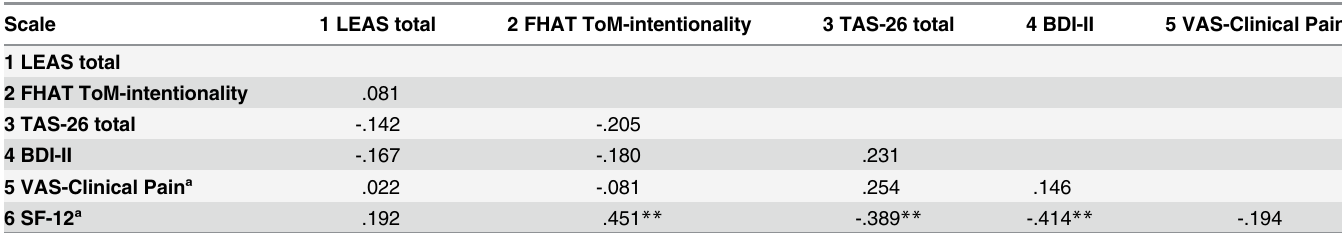
Table 3. Associations between measures of ToM, Emotional Awareness, and clinical parameters within the patient group.